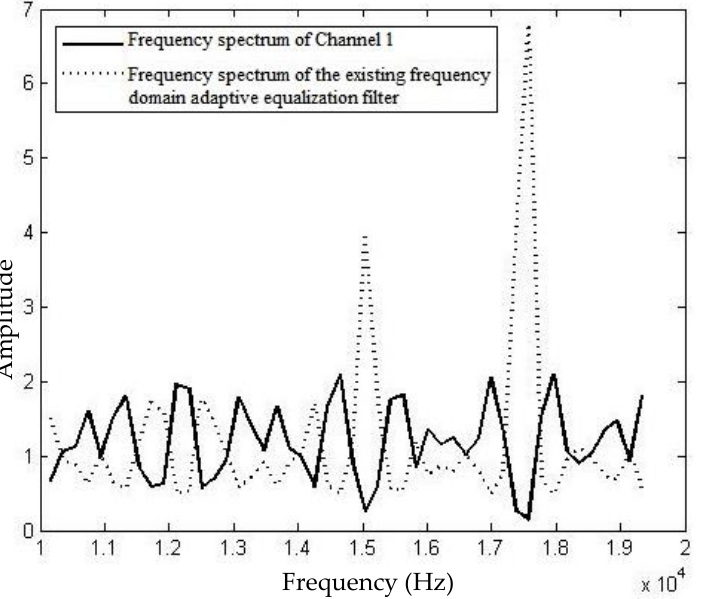
Figure 3. Compensation for Channel 1 with the existing frequency domain equalization algorithm.